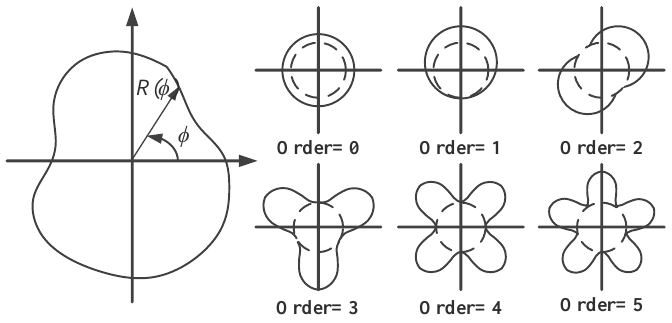
Figure 1. Cylindrical coordinate system and Fourier orders.